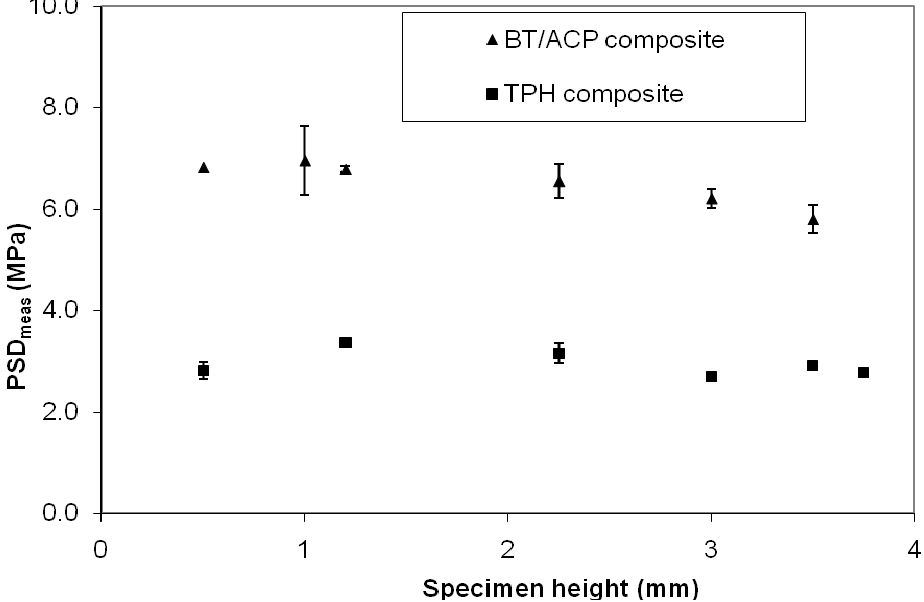
Figure 1. PSD as a function of specimen height. Indicated are the mean values ± one meas standard deviation (SD). Number of runs n= 3/experimental